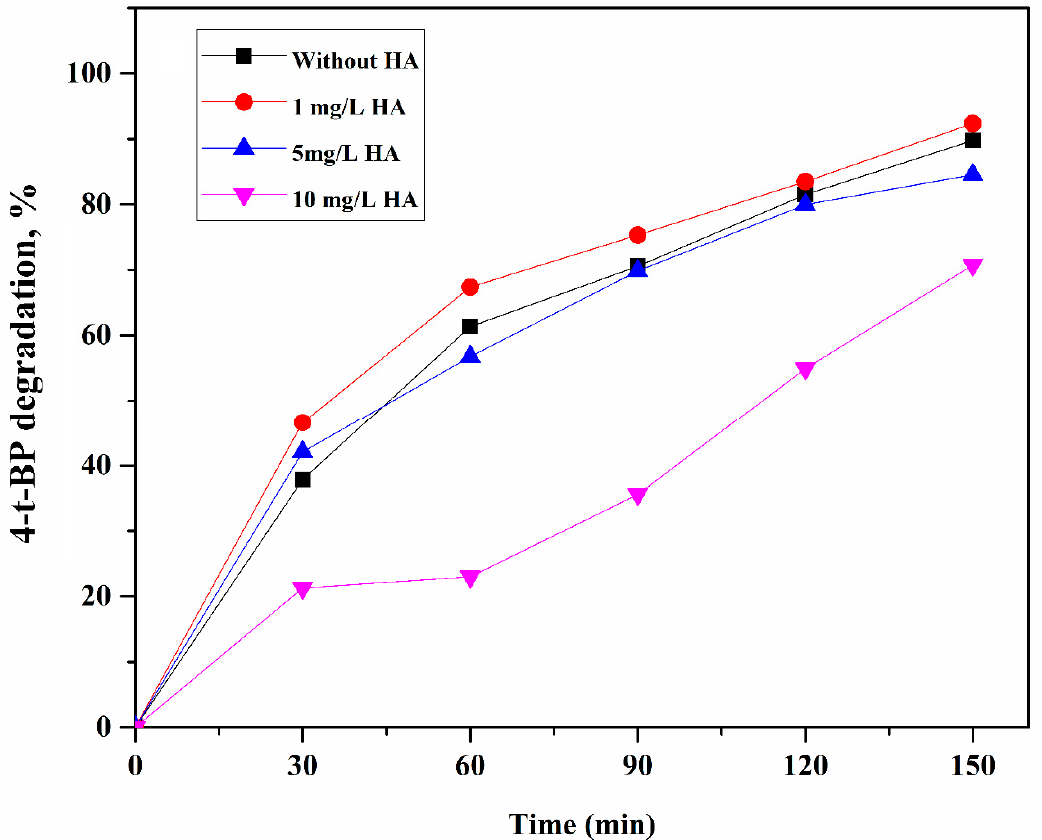
Figure 16. Effects of HA on 4-t-BP degradation under solar irradiation in the presence of mTiO-650. Reaction conditions: [4-t-BP] 0 = 5 mg/L, [photocatalyst] = 200 mg/L.